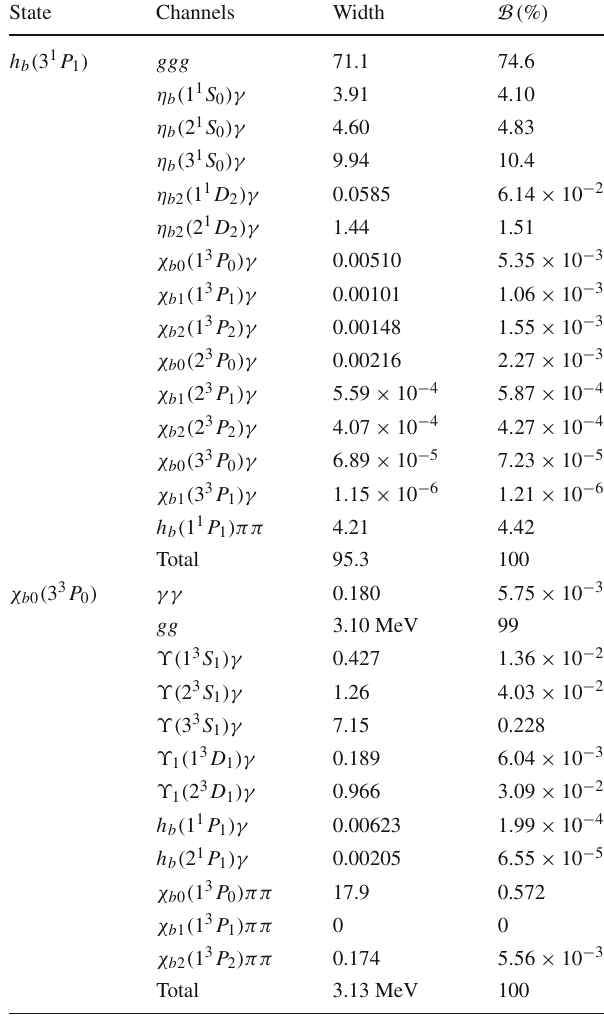
Table 8 Partial widths and branching ratios of annihilation decay, radiative transition, and hadronic transition and total widths for 3 1 P 1 and 3 3 P 0 bottomonium states. The width results are in units of keV 100 State Channels